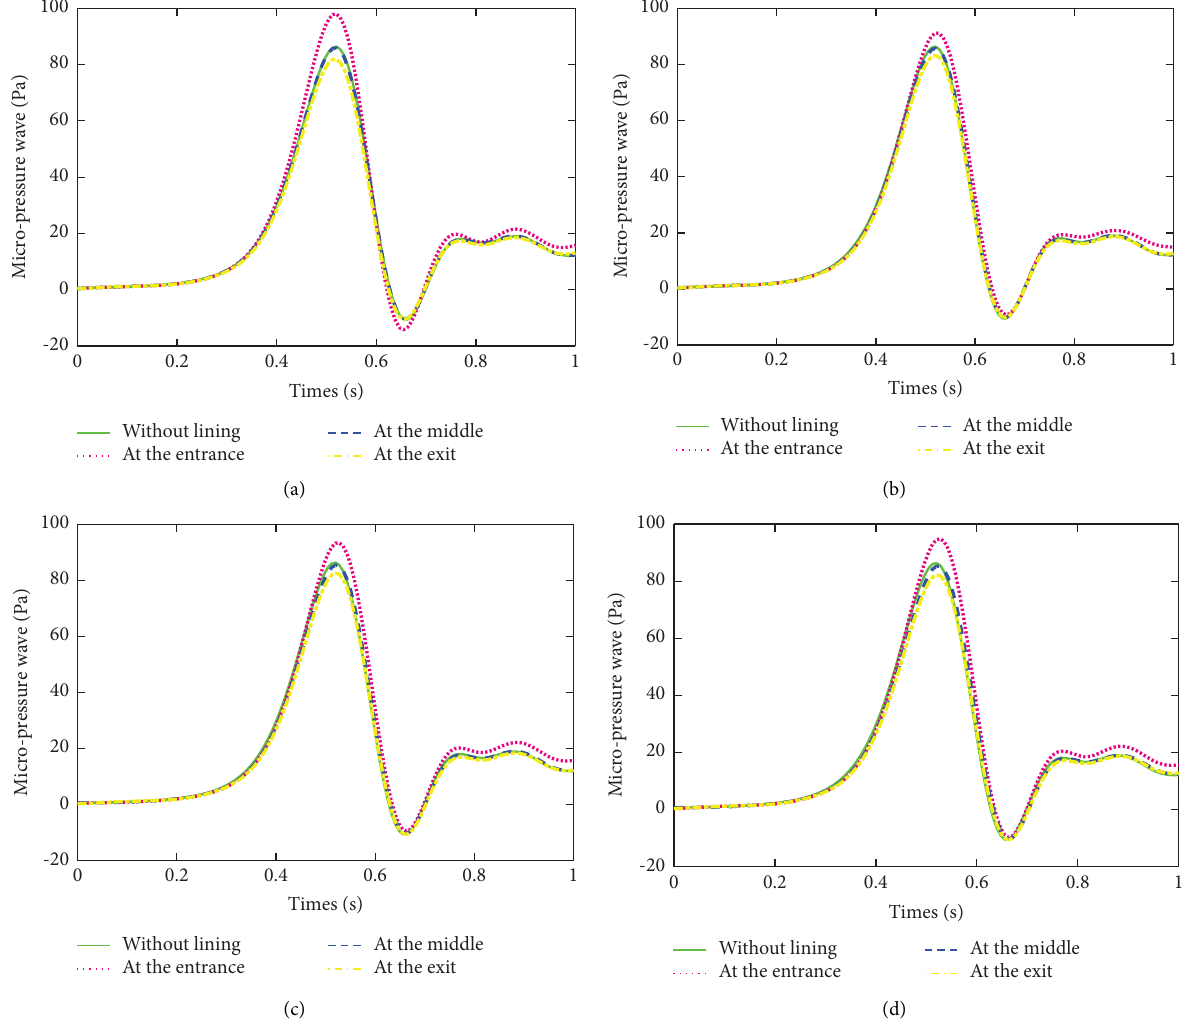
Figure 8: Comparison of the micro-pressure wave at M 1. (a) Normal linings. (b) 10-segment linings. (c) 20-segment linings. (d) 30-segment